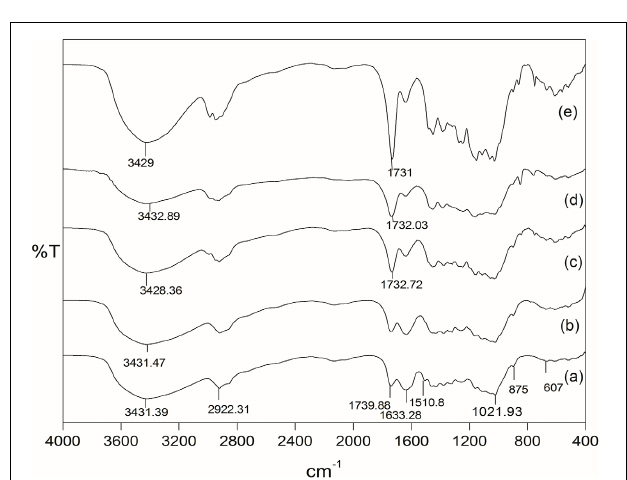
Figure 4 | FTIR spectra of (A) raw Grewia optiva , (B) delignified Grewia optiva fibre, (C) dGo-poly(MMA), (D) dGo-poly(MMA-co-EA), and (E)